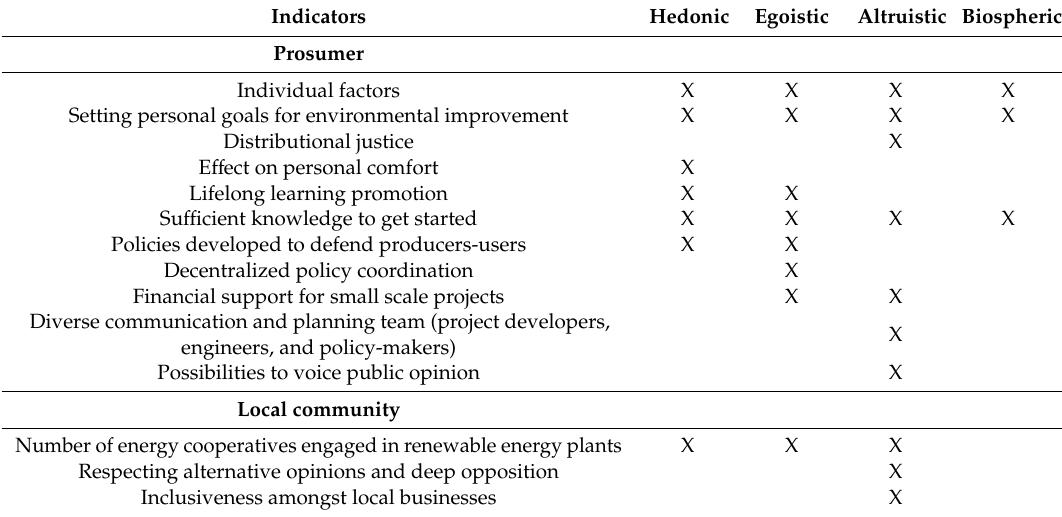
Table 7. Classification of site-specific analysis indicators based on the values system [35]. Indicators Hedonic Egoistic Altruistic Biospheric Prosumer Individual factors X X X X X X X